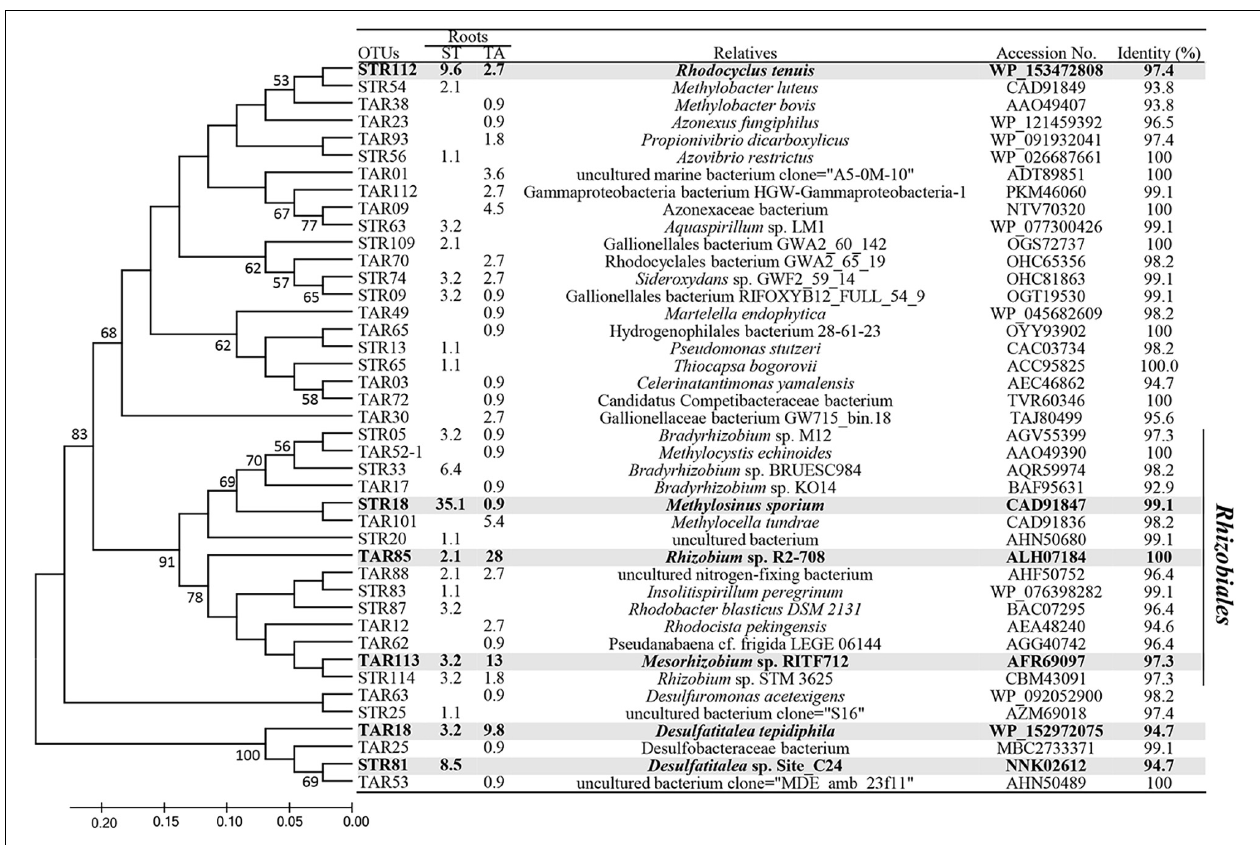
FIGURE 4 | Phylogenetic distribution of representative operational taxonomc units (OTUs) of ( ≥ 94% amino acid identity) based on translated nifH gene sequences from the roots of Scirpus triqueter and Typha angustifolia . The table shows the relative abundance of OTUs in each library and the results of a BLAST search using the representative sequences. The tree was constructed using the neighbor-joining method, and the bootstrap values (%) for each branch were determined using 1,000 iterations. Bootstrap values ( > 50%) are shown to the left of nodes in the tree. The main OTUs ( > 5% relative abundance) are shown in